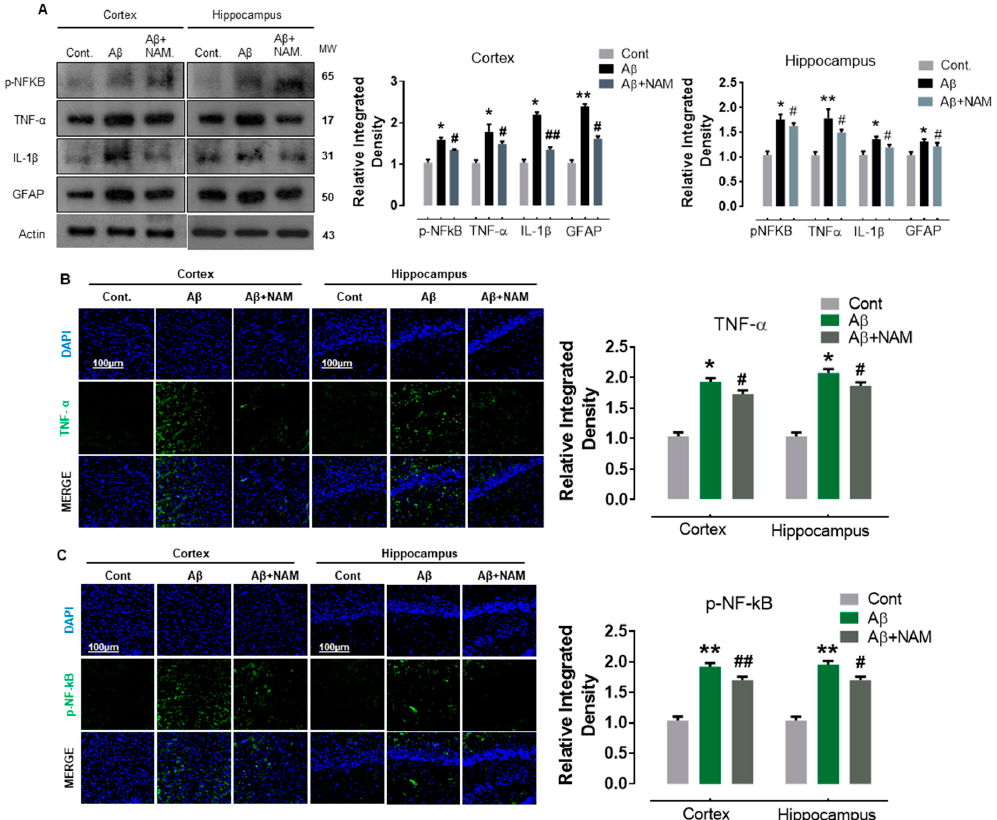
Figure 3. NAM decreases the expression level of proinflammatory cytokines in A β 1–42 -induced Mouse Brains ( A ) Shows the Western blot results of inflammatory cytokines, i.e., p-NF-kB, TNF- α , GFAP and IL-1 β both in cortex and hippocampus. 6 animals were kept per group. ( B , C ) indicating the confocal results of TNF- α , and p-NF-kB. Experiments were repeated 3 times and the scale bar was kept 100 µm. “Asterisk sign (*) indicated significant difference between control and A β injection group; hash sign (#) indicated significant difference between A β injection group and A β + NAM treated group. Significance: (*) # = p ≤ 0.05, (**) ## = p ≤ 0.01.”.